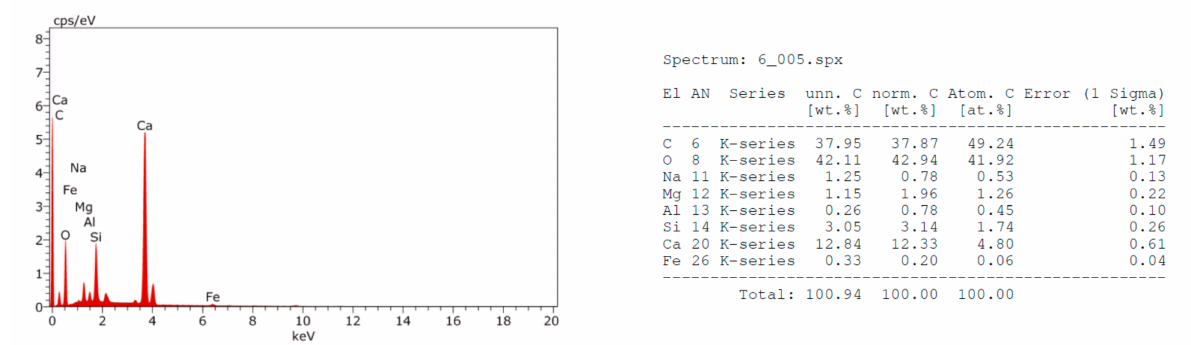
Figure 4. EDX analysis of Mix C fractured surface.